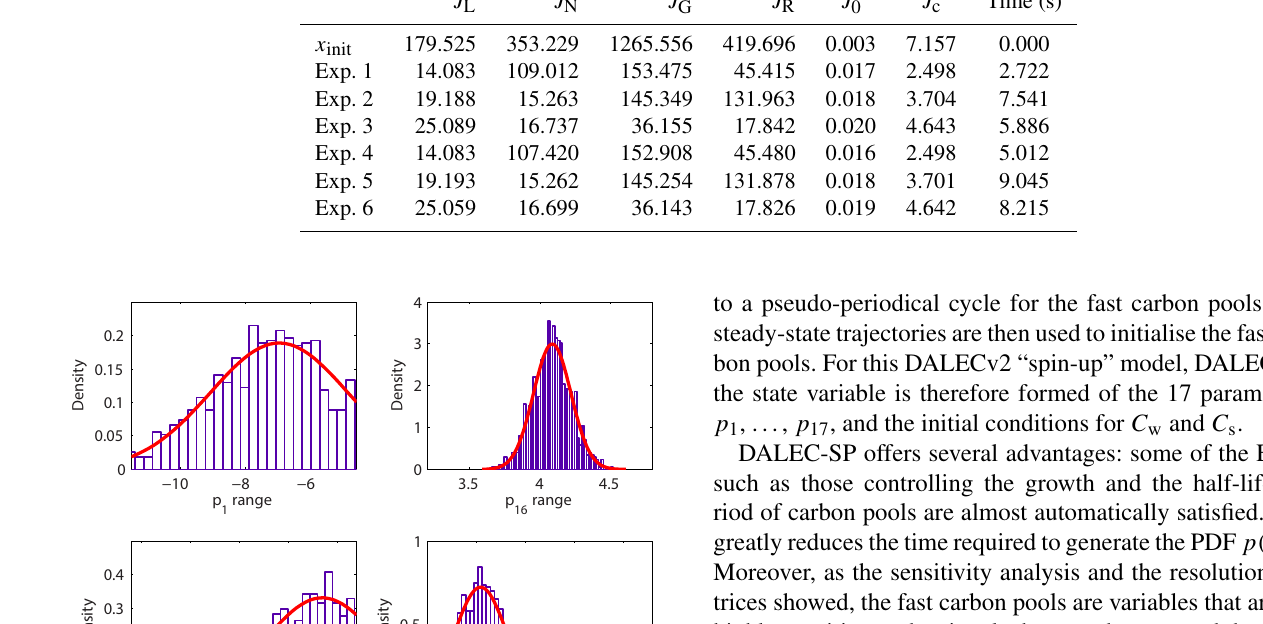
Table 4. Costs for the results of the inverse modelling experiments. The last column reports the computation time in seconds for the experi- ment. J L